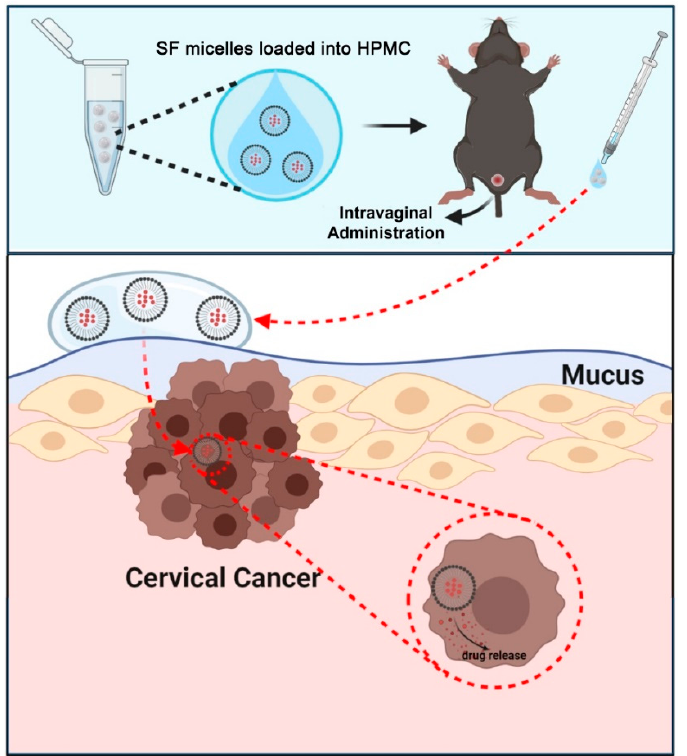
Scheme 1. Treatment of sorafinib micelles dispersed in HPMC after intravaginal administration in an an orthotopic mouse cervicovaginal cancer model. Created with BioRender orthotopic mouse cervicovaginal cancer model. Created with BioRender (https://biorender.com/).